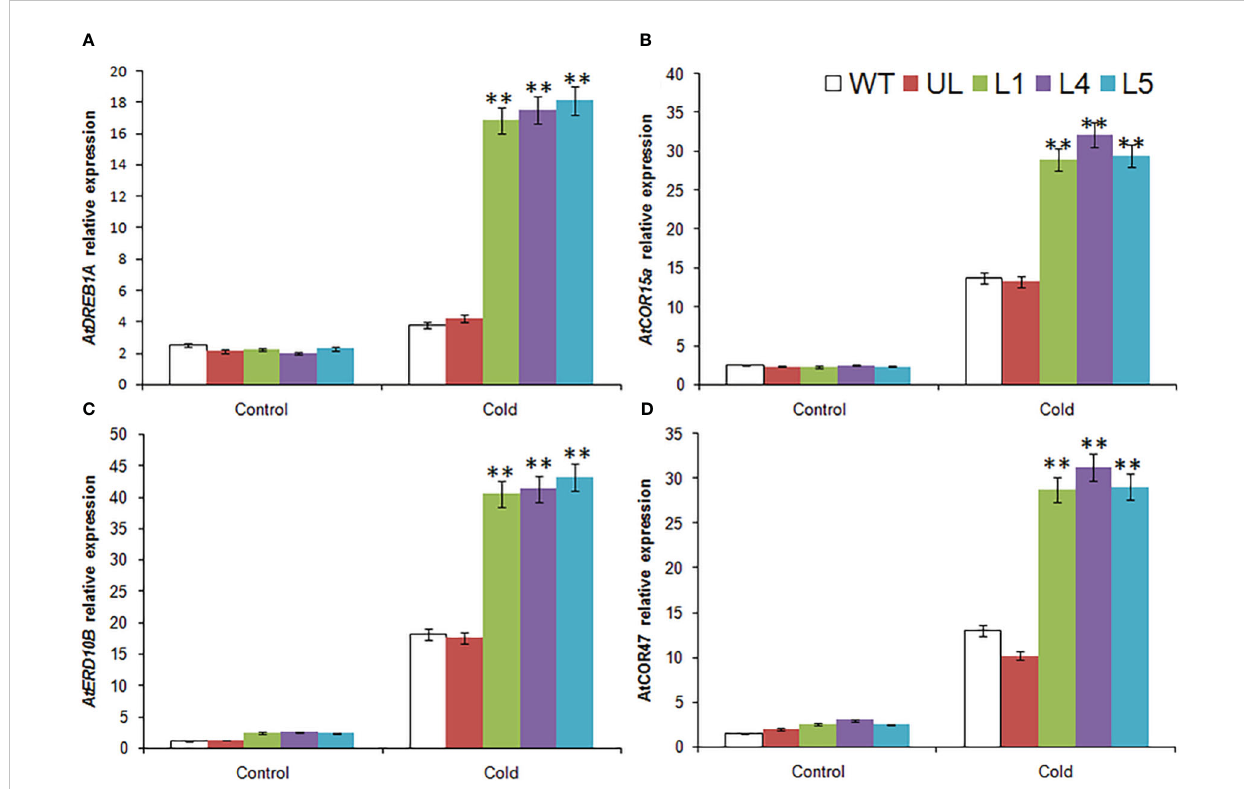
FIGURE 7 Expression of 4 cold stress related genes in A. thaliana . The expression leave of (A) AtDREB1A , (B) AtCOR15a , (C) AtERD10B and (D) AtCOR47 . (**, P ≤ 0.01). The control was the index in the WT. All data were the average of 3